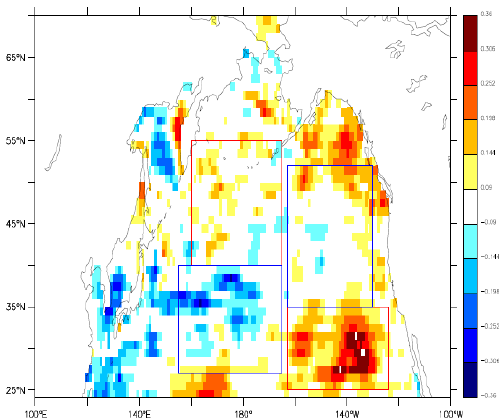
Figure 8: Partial correlation between net air-to-sea CO 2 flux anomalies and PDO after removing the 3 Fig. 8. Partial correlation between net air-to-sea CO 2 flux anoma- correlations between CO 2 flux anomalies and ENSO. CO 2 flux data from assimilation are used. 4 Correlations significant at 90% confidence interval are shaded. 5 lies and PDO after removing the correlations between CO 2 flux 6 anomalies and ENSO. CO 2 flux data from assimilation are used. Correlations significant at 90% confidence interval are